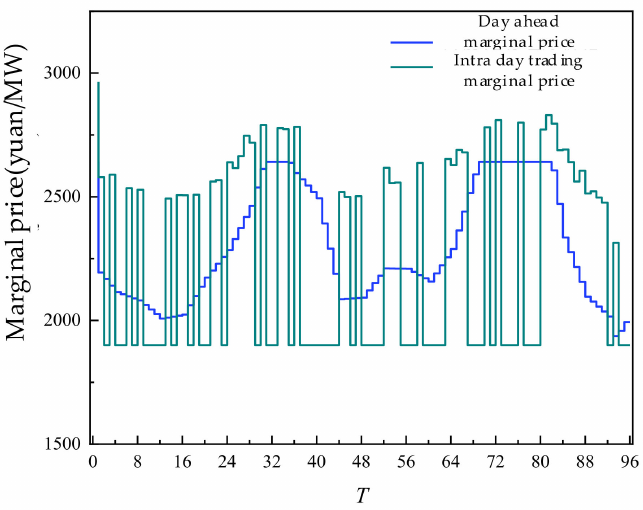
Figure 17. Marginal price of monthly, day-ahead, intra-day trading in